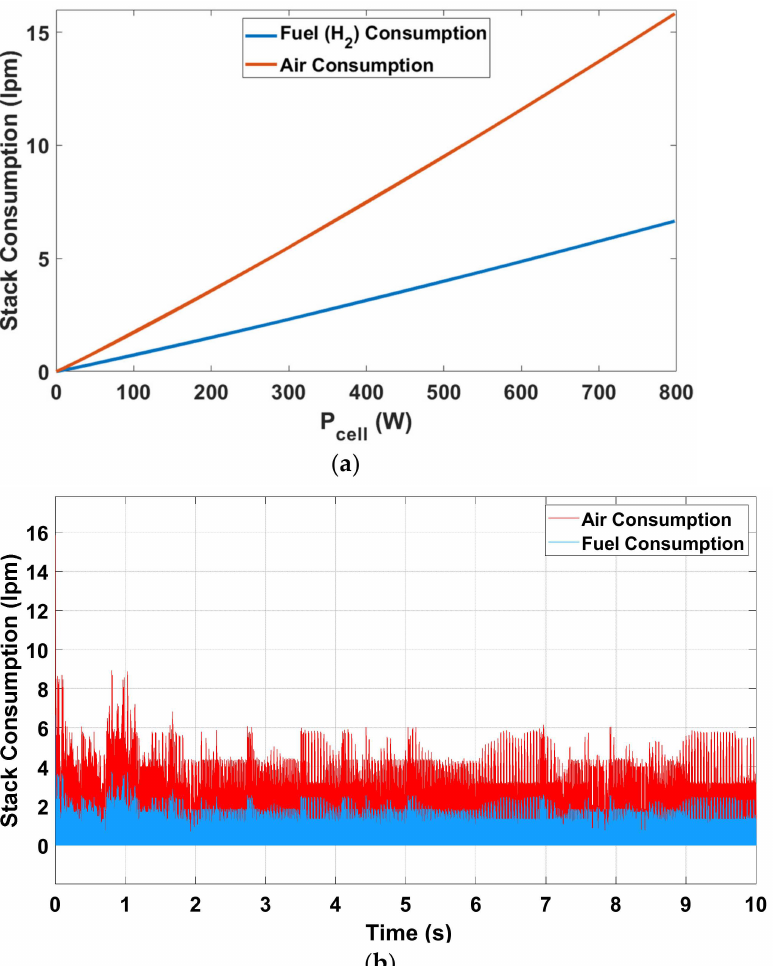
Figure 13. ( a ) The variation of the fuel and air consumption of the PEM fuel cell as a function of consumed power from the fuel cell during the spiral route tracking of AGV. ( b ) The variations in fuel and air consumption of the PEM fuel cell as a function of